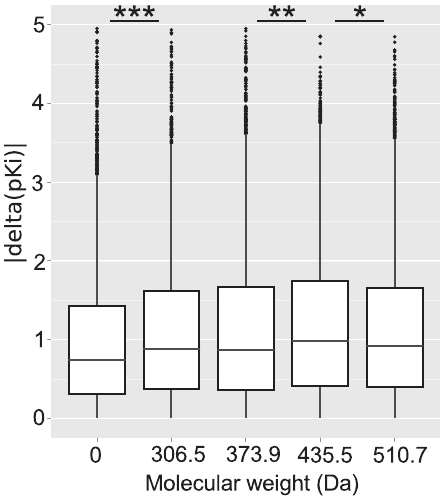
Figure 4. Molecular weight and absolute differences in binding affinity. Box plots show distributions of differences in binding affinity for small molecules grouped by equally sized molecular weight bins for paralogs. Each bin contains the same number of values and lower bin limits are shown below each box. Anova type multiple testing was carried out to assess the significance of differences between neighbouring groups and levels of significance are indicated with one ( p v 5 (cid:2) 10 { 2 ), two ( p v 5 (cid:2) 10 { 5 ) or three asterisks ( p v 5 (cid:2) 10 { 10